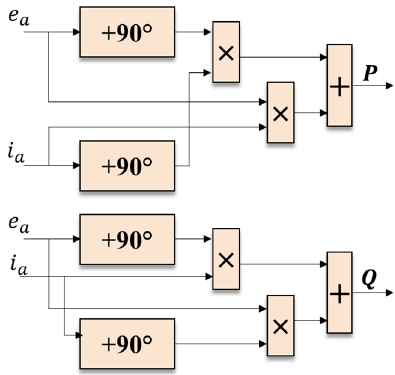
Figure 6. Power calculation by Math Operations with a filter. Active power calculation (top). Reactive Power calculation (down).